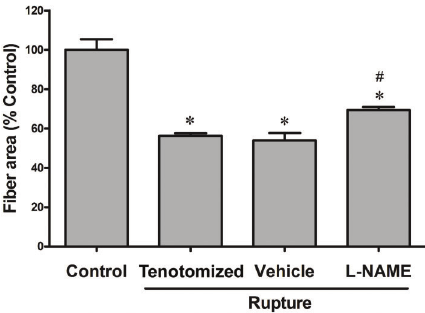
Figure 3. Quanti fi cation of muscle fi ber areas. Muscle samples were obtained on day 21 after tenotomy from all experimental groups. About 200 fi bers per animal were evaluated. Fiber area is reported as means ± SD in percent of control for n X 4 rats/group. *P o 0.05 vs control. #P o 0.05 vs tenotomized and vehicle